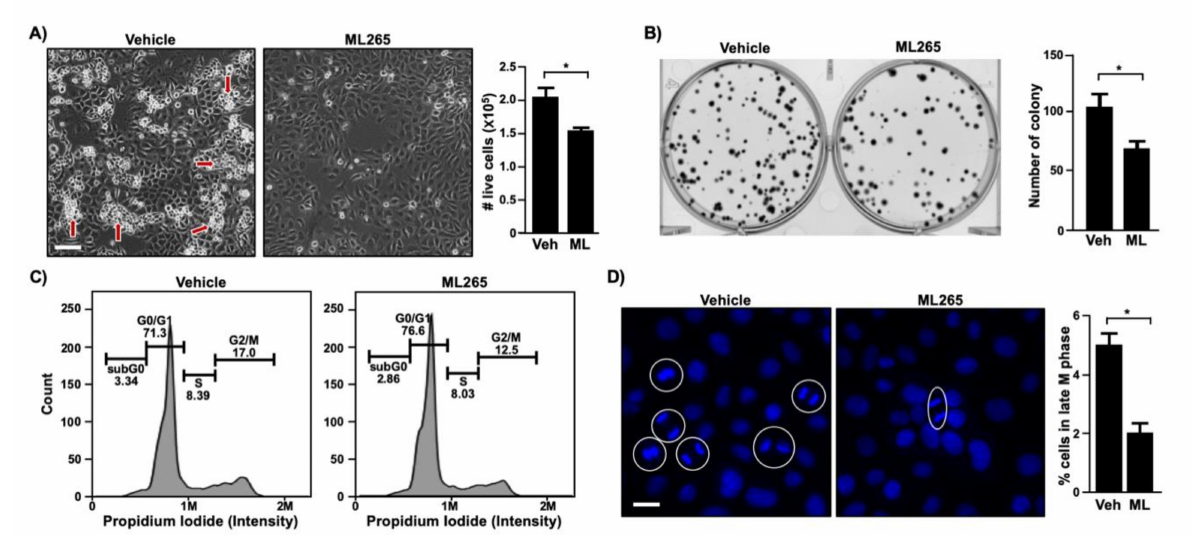
Figure 5. ML265 inhibits cell cycle progression and colony formation in cervical cancer cells. ( A ) SiHa cells were seeded in 24-well plates (20,000/well) and treated with vehicle (veh) and 40 µ m of ML265 (ML) for 5 days. The left panel shows photographed cells (scale bar, 100 µ m). Red arrows point to cells growing on top of other cells. The right panel shows cell counting results as mean ± S.E.M. ( n = 3). * p = 0.03 (two-sided Student’s t -test). ( B ) SiHa cells were seeded in 6-well plates (100 cells/well) and treated with 40 µ m of ML265 for 2 weeks. Cells were stained with crystal violet and photographed ( left panel ). Quantified results ( right panel ) are shown as mean ± S.E.M. ( n = 3). * p = 0.04 (two-sided Student’s t -test). ( C ) SiHa cells were treated with ML265 (40 µ m) for 24 h. Cell cycle was analyzed with flow cytometry. Shown are representative results from two independent experiments with triplicate samples ( p < 0.05, Student’s paired t -test). At least 10,000 cells per sample were analyzed. ( D ) SiHa cells were treated with ML265 (40 µ m) for 24 h and stained with Hoechst 33342 to visualize DNA (blue). Random fields of view were photographed, and mitotic cells were quantified. The left panel shows the representative images of each group (scale bar, 50 µ m). Cells in anaphase and telophase are circled, and each circle is counted as one cell. More than 1,000 cells per sample were analyzed. Quantification results are shown in the right panel as mean ± S.E.M ( n = 3). * p = 0.003 (two-sided Student’s t